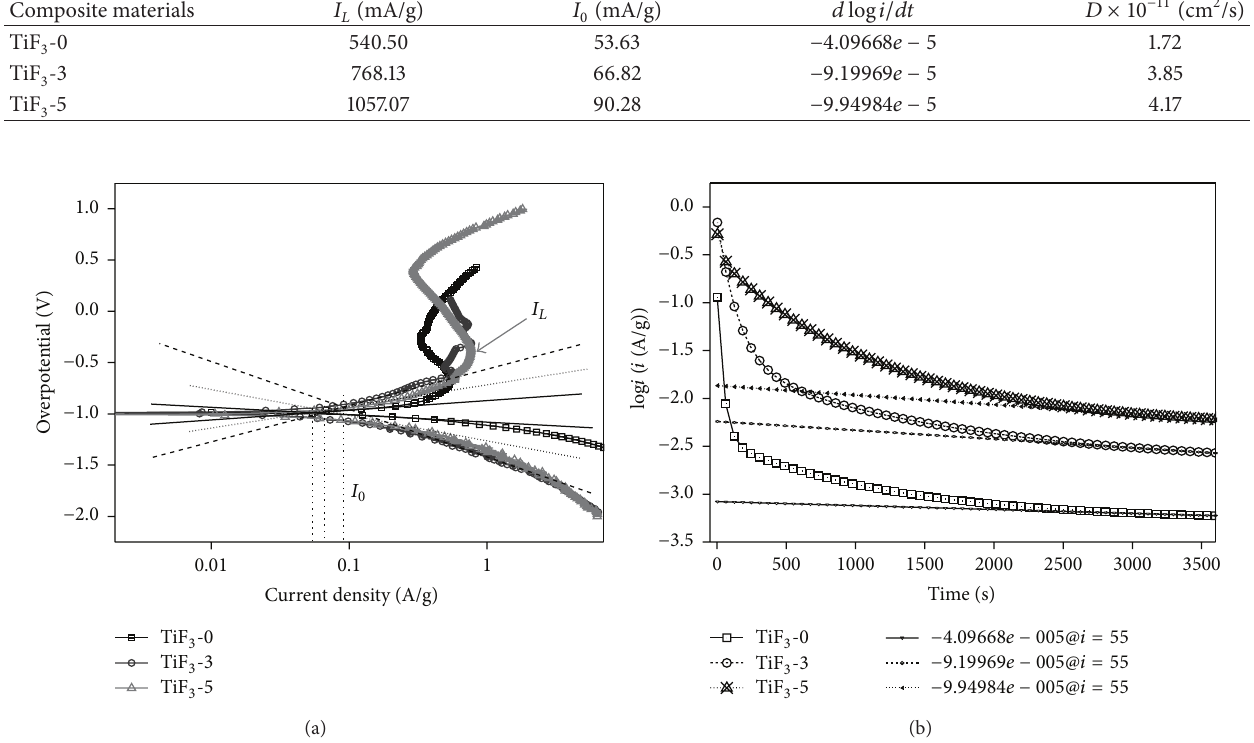
Mg + 150 wt.% Ni + 𝑦 wt.% TiF 2 17